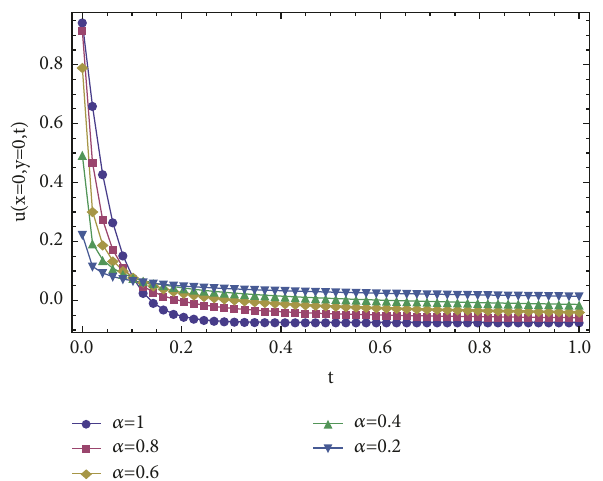
Figure 4: Plot of 𝑢(𝑥 = 0, 𝑦 = 0, 𝑡) for various values of 𝛼